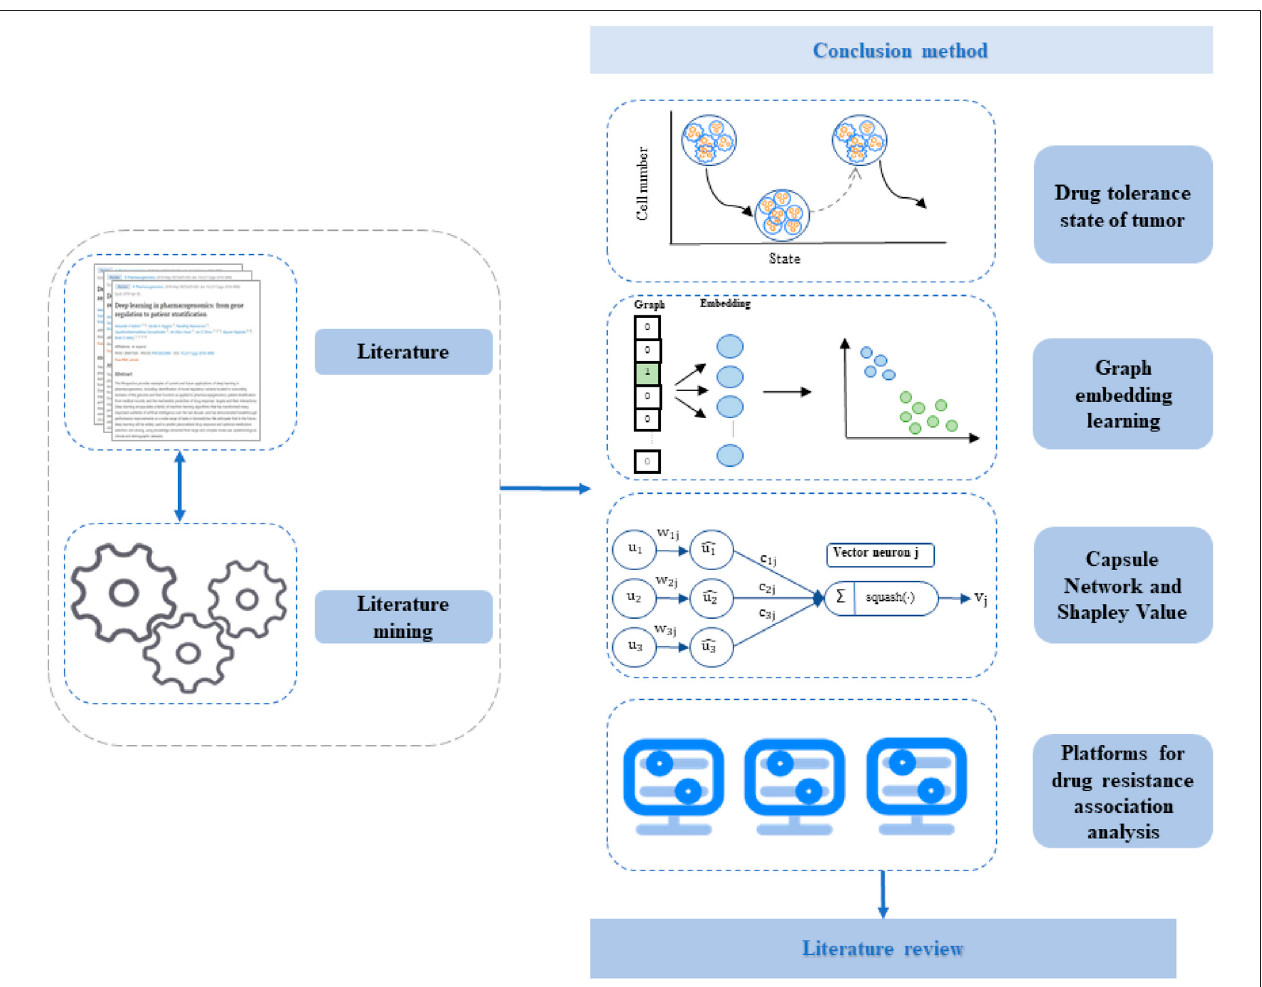
FIGURE 1 | Schematic of the